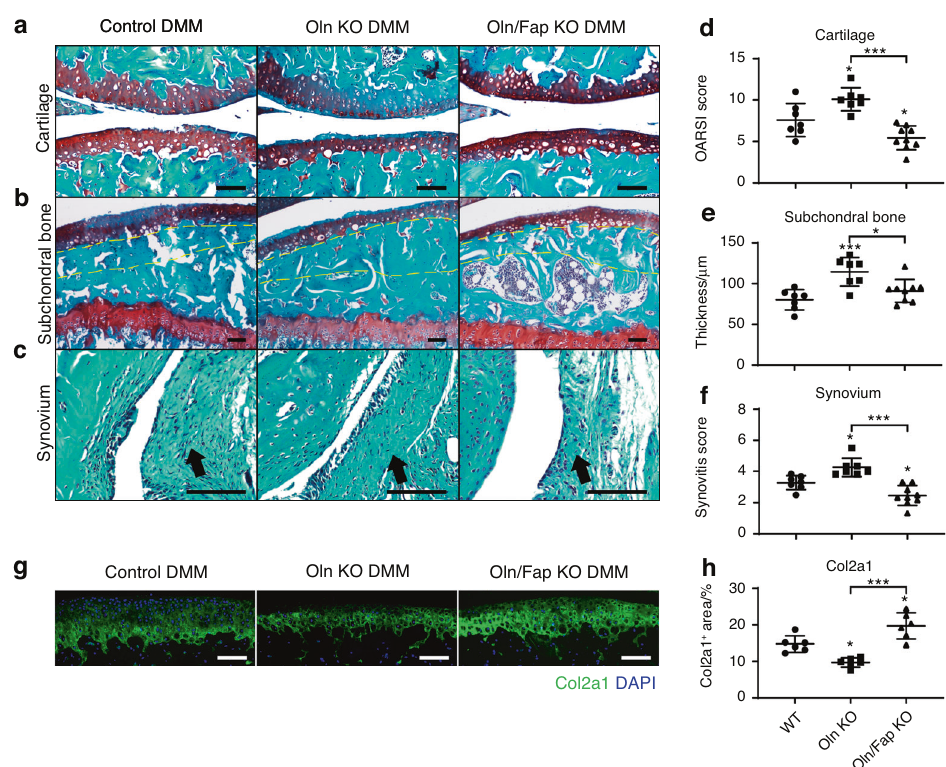
Fig. 7 Oln inhibits OA progression in a Fap-dependent manner. a – c Safranin O/Fast Green staining in control, Oln KO and Oln/Fap double KO mouse knee joints 8 weeks after DMM surgery. DMM surgery was performed in 10-week-old mice. Representative cartilage erosion ( a , top: femur, bottom: tibia), subchondral bone thickening ( b ) and synovitis ( c ) images are shown ( n = 7 – 9 mice per genotype). Yellow dotted lines indicate the subchondral bone plate. Arrows indicate the synovium. Scale bars: 100 μ m. d – f Quanti fi cation of the OARSI score ( d ), subchondral bone thickness ( e ) and synovitis score ( f ). g , h Immunostaining of Col II in the knee joints ( g ) with quanti fi cation ( h ) ( n = 6 mice per genotype). DAPI staining indicates the nucleus. Scale bars: 100 μ m. The statistical signi fi cance was assessed using one-way ANOVAs with Tukey ’ s multiple comparison tests. Data are presented as the mean ± SD (* P < 0.05, ** P < 0.01, *** P < Intra-articular injection of recombinant Oln attenuates OA Col2a1 levels in primary chondrocytes after IL-1 β stimulation, progression while there was a modest but signi fi cant increase in Mmp3 levels To test whether recombinant Oln (rOln) showed similar therapeutic compared to those in wild-type controls (Fig. S11a – e). Taken effects as those of FAPi, we administered weekly intra-articular together, these fi ndings indicate that the genetic deletion of Oln injections of recombinant rOln (240 μ g·kg − 1 body weight) or exacerbates OA progression, which could be partially rescued by Fap deletion or inhibition. vehicle control (0.05 mg·mL − 1 hyaluronic acid) in wild-type mice